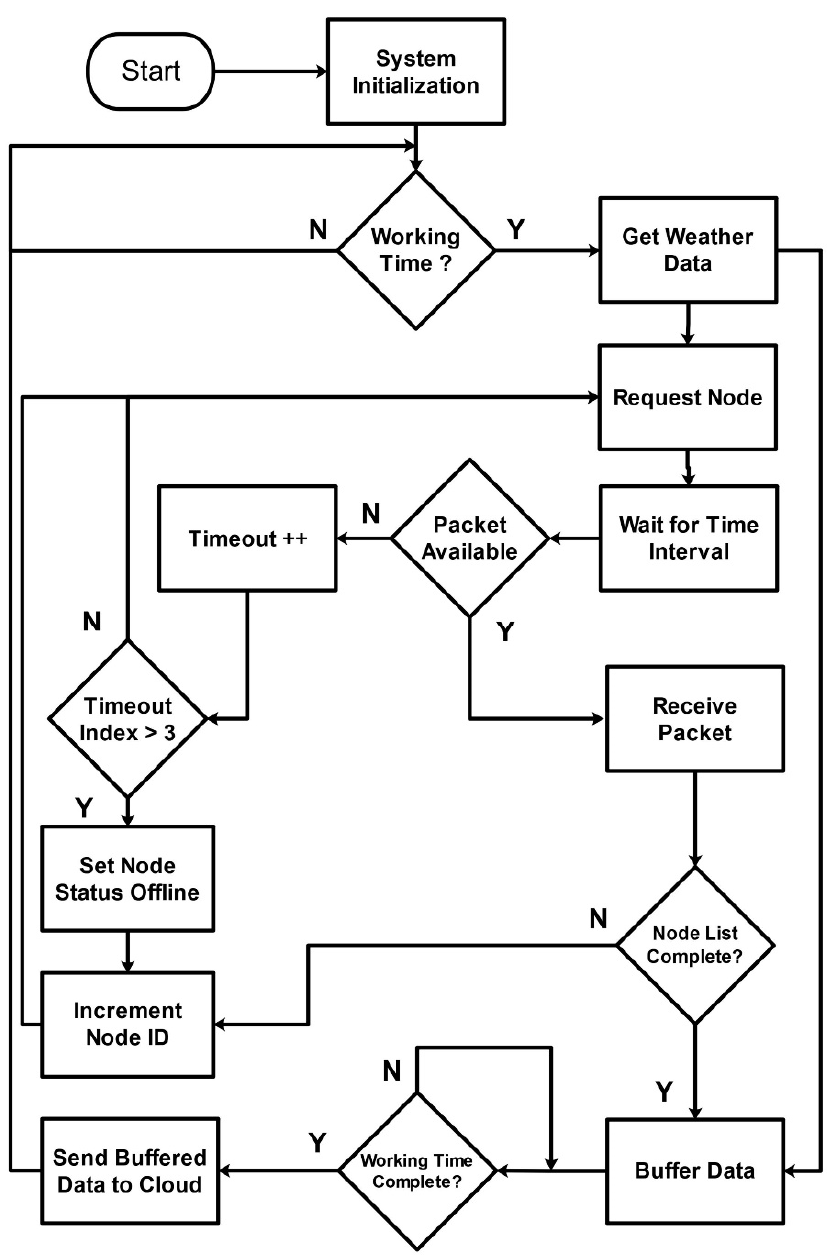
Figure 7. Flow diagram of gateway node